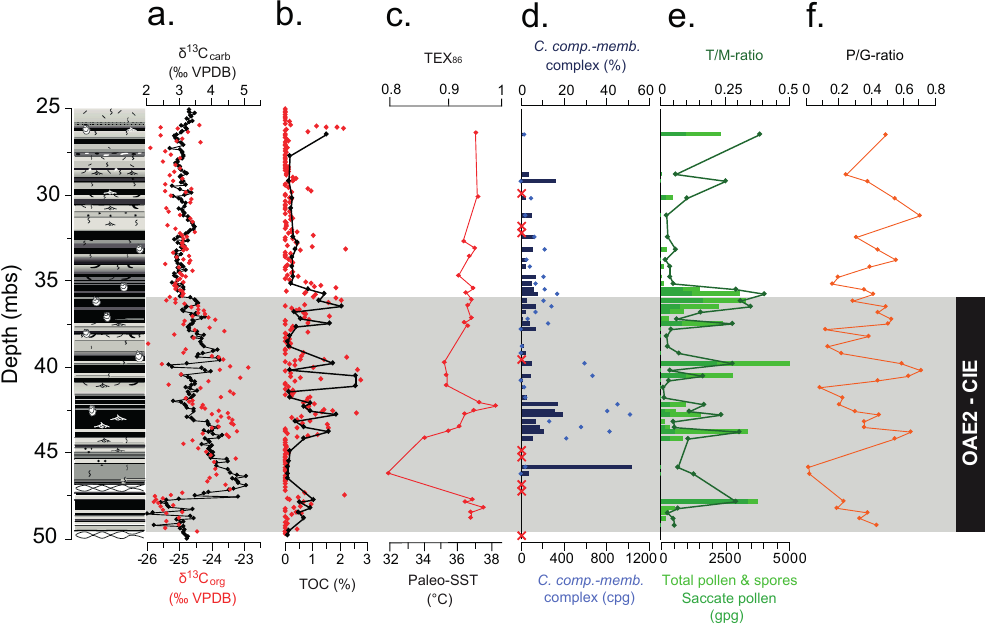
Figure 6. Geochemical and palynological results for the Cenomanian–Turonian transition of the Wunstorf core. Stratigraphy from Voigt et al. (2008). (a) δ 13 C carb (Voigt et al., 2008) and δ 13 C org (du Vivier et al., 2014; red). (b) Total organic carbon (TOC: black, this study; red, Hetzel et al., 2011). (c) TEX 86 values and TEX H -based SST reconstruction (Kim et al., 2010). (d) Relative abundance (%) and absolute 86 abundance in cysts per dry gram of sediment (cpg), of the dinocyst species Cyclonephelium compactum – C. membraniphorum complex, “X” represents barren samples. (e) Terrestrial vs. marine palynomorphs (T / M ratio) and total pollen and spores in grains per dry gram of sediment (gpg), saccate gymnosperm pollen in dark green. (f) Peridiniod vs. gonyaulacoid dinocysts (P / G ratio). The grey zone indicates the OAE2 interval after Voigt et al. (2008). Table 1. Overview of the different sites for which TEX 86 -paleothermometry was applied over the OAE2 interval, and TEX 86 values and paleo-SST ranges and